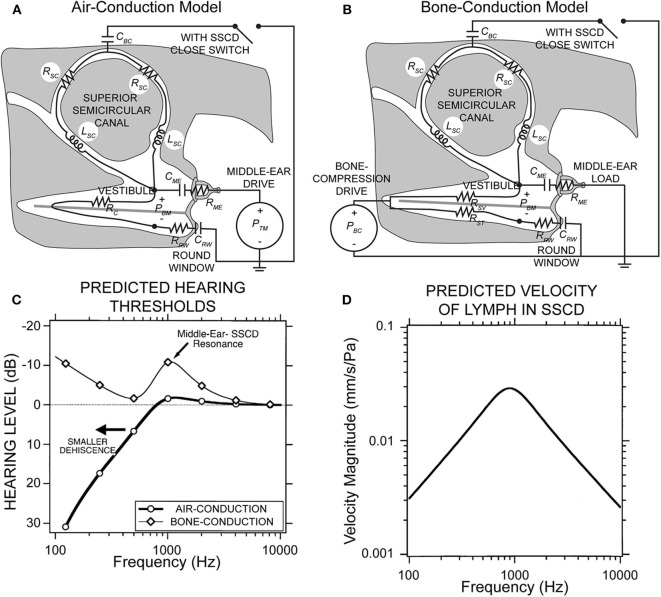
Lumped parameter network model of the inner and middle ear with and without SSCD. (A) Air-conduction model where the drive is sound pressure from the ear canal, PTM. (B) Bone-conduction model where the drive is effective sound pressure of the vibratory bone-conducted stimulus, PBC. (C) The peak in the bone-conduction thresholds is due to a parallel resonance between the compliance of the middle ear load and the inertance of the fluid in the canal limbs. A smaller dehiscence would shift both curves left to lower frequencies. (D) Predicted velocity of vestibular lymph fluids in an SSCD with air-conducted sound. Republished from (49), with permission. The Creative Commons license does not apply to this content. Use of the material in any format is prohibited without written permission from the publisher, Wolters Kluwer Health, Inc. Please contact permissions@lww.com for further information.